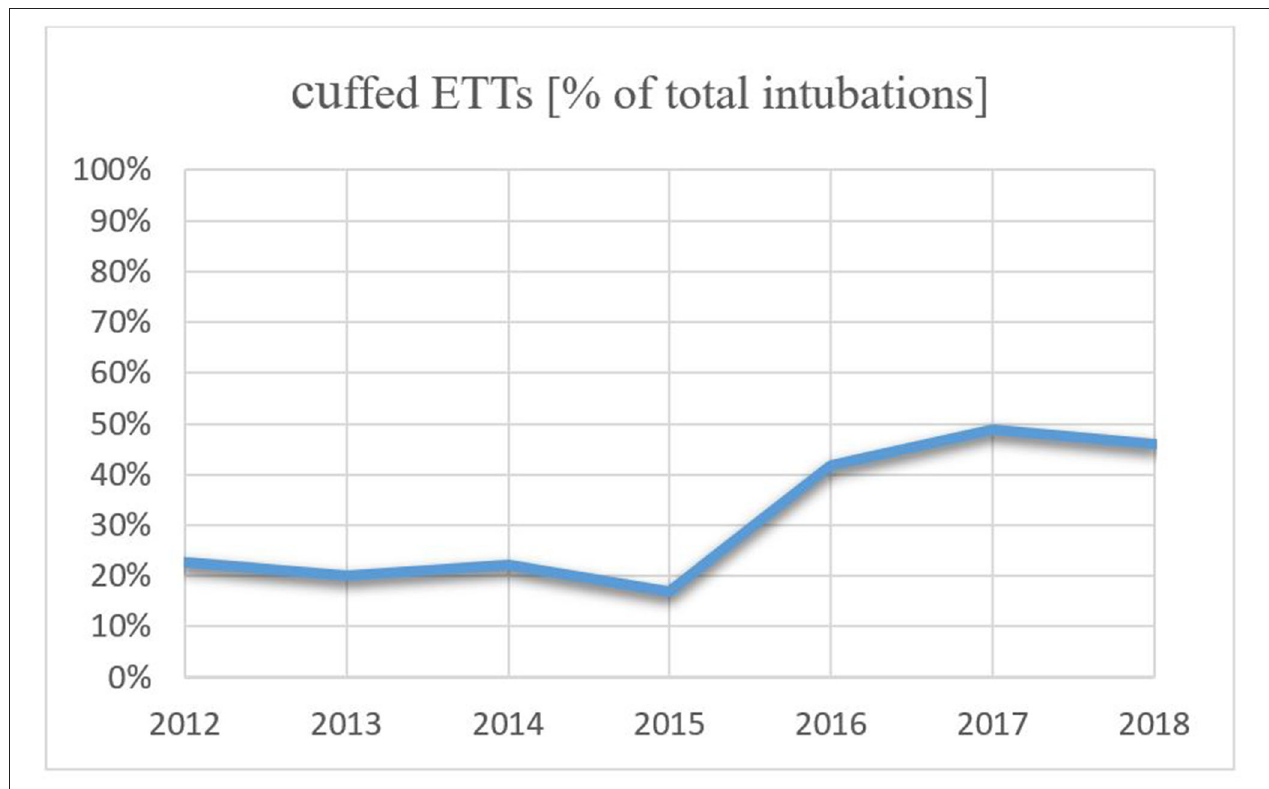
FIGURE 2 | Trend of use in cuffed ETTs from 2012 to 2018.